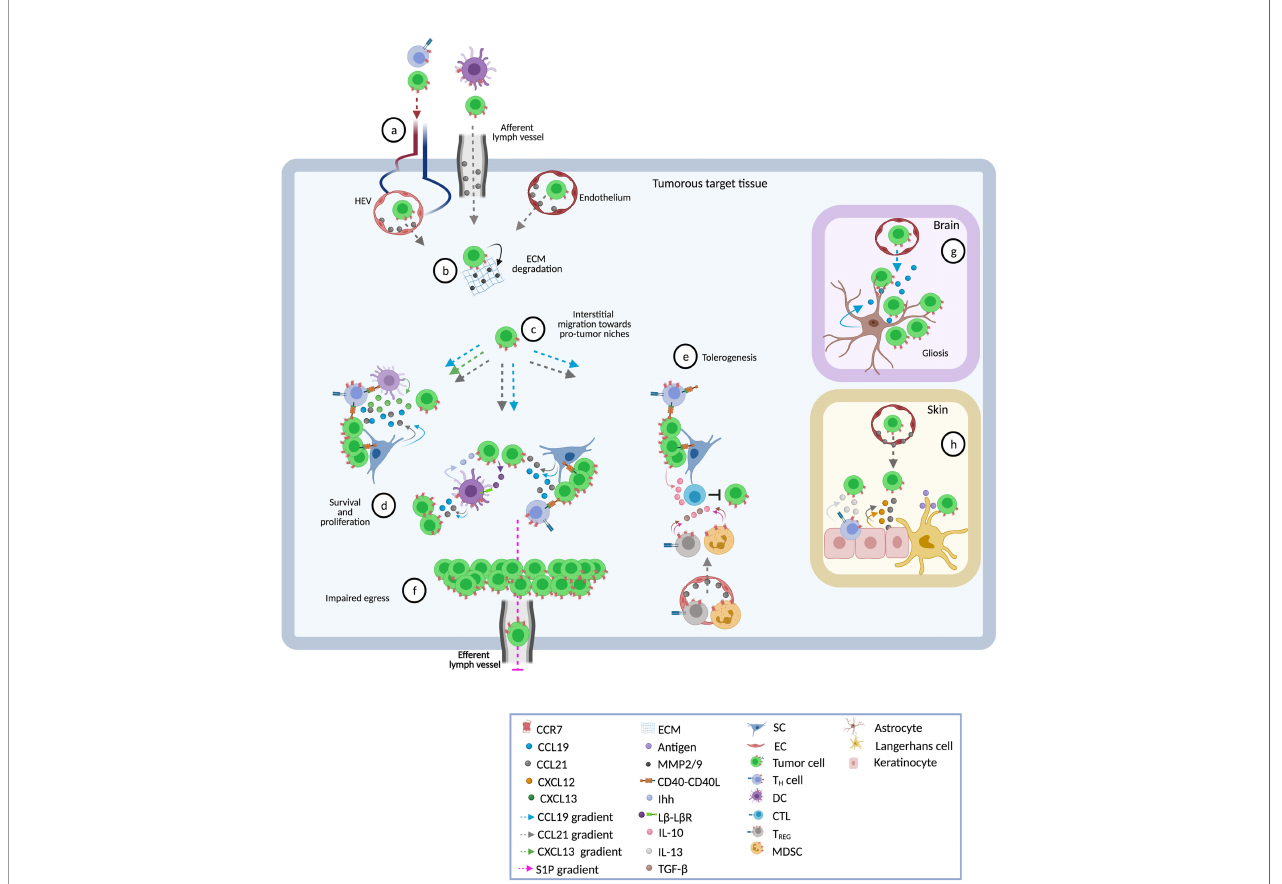
FIGURE 2 | Pathophysiological roles of CCR7 in blood cancers. Shown are different tissues and ways in which the receptor contributes to disease progression. (A) Following CCL21 gradients, CCR7-expressing tumor and accessory cells enter into target tissues through high endothelial venules (HEV, in LN and other SLO), afferent lymphatic vessels (in LN), or endothelial cells (BM, spleen, skin, CNS) (8 – 10, 24, 25, 104, 130, 134). CCL21 on the surface of endothelial cells (EC) activates a 4 b 1 and a L b 2 integrins thus facilitating transmigration (35, 58, 64, 130, 157). (B) Subsequently, activated CCR7 promotes invasive phenotypes that secrete metalloproteinases 2 and 9 (MMP-2/9) and promotes extracellular matrix (ECM) degradation (64, 130, 183, 184). (C) Within the tissue, CCR7 drives interstitial migration of tumor cells to distinct sites such as T-zones or B-zones in spleen and LN (9), or to lymphoid-like (tertiary) structures in skin or CNS (104, 169). Some tumor cells have inherent abilities to migrate towards CCL19/CCL21 gradients whereas others need cooperative signaling by other chemokines (e.g. CXCL12 or CXCL13) or a previous stimulus, such as exposure to CD40L, to initiate this process (20, 22, 23, 78, 90, 183, 209). (D) CCR7-driven interstitial migration assists tumor cells in their right positioning adjacent to accessory cells such as CD40L + CD4 + T H cells, DC, and stromal cells (SC) which foster growth and resistance to spontaneous or drug-induced cell death (9, 68). Cross-talk with accessory cells induces the release of CCL19 and CCL21 (9, 25, 134) directly promoting survival and proliferation of tumor cells via MAP-kinase and PI3K signaling pathways (9, 40, 70, 223). CCL19 can also act in cooperation with CXCL13 to confer resistance to TNF- a -mediated apoptosis via up-regulation of PEG10 (26, 27). Other pro-tumor factors delivered by accessory cells include the Indian hedgehog (Ihh) secreted by fi broblastic reticular cells (FRC) and CD40 stimulation through CD40 ligand-expressing CD4 + T H cells (9). In turn, malignant cells secrete factors that stimulate and protect accessory cells. One of these factors is lymphotoxin through which tumor cells stimulate lymphotoxin- b -receptor (L b R) expressing FRC (9). Finally, in these niches enhanced production of CCR7 ligands establishes a self-enhancing loop that recruits more tumor and accessory CCR7-expressing cells favoring the continuation of pro-tumor microenvironments (9, 25, 134, 161, 169, 221). (E) CCR7 ligands may attract CCR7 + immunosuppressive cells such as T REG and myeloid- derived suppressor cells (MDSC) (224, 225). These suppressor cells inhibit anti-tumor effector cells (e.g. CTL) through cell-cell interactions or by creating a tolerant milieu enriched in suppressor cytokines like IL-10 and tumor growth factor beta (TGF- b ) (22, 28, 225, 226). Similarly, CCL19 and CXCL13 may synergistically regulate CD40-CD40L cross-talk between cancer cells and CD8 + T-cells leading to a PEG10-mediated enhanced production of IL-10 in CD40-activated tumor cells that inhibits tumor-speci fi c CTL (28). Together, these CCR7-induced mechanisms facilitate permissive milieus within tumor target tissues. (F) CCR7 also prolongs the time of residence of CCR7-expressing cells in lymphoid tissues (i.e. LN) thus favoring proliferative cycles and providing niches of escape from systemic therapies. In the steady state, internalization of CCR7 activates the transcription and surface expression of S1P1, facilitating the egress of lymph-node-homed immune cells through efferent lymphatic vessels (71). Tumor-associated overexpression of CCR7 impairs S1P1 upregulation thus retaining tumor cells within the LNs, reducing the egress and causing lymphadenopathy (43, 46, 72). ( G) In CNS, astrocyte-derived CCL19 attracts tumor cells and enhances their parenchymal retention thus contributing to gliosis (24, 25, 104). Inside cerebral or spleen parenchyma, cross-talk between stromal cells and leukemic cells mediates the production of higher levels of tissue CCL19 (25, 134) facilitating the in fi ltration of tumor cells. (H) In the skin, CCL21 in the cytoplasm of epidermal keratinocytes and to be diffusely distributed in the dermal extracellular matrix may lead tumor cells to milieus enriched in growth factors such as CXCL12, IL-13 or antigens able to entertain chronic T-cell receptor stimulation